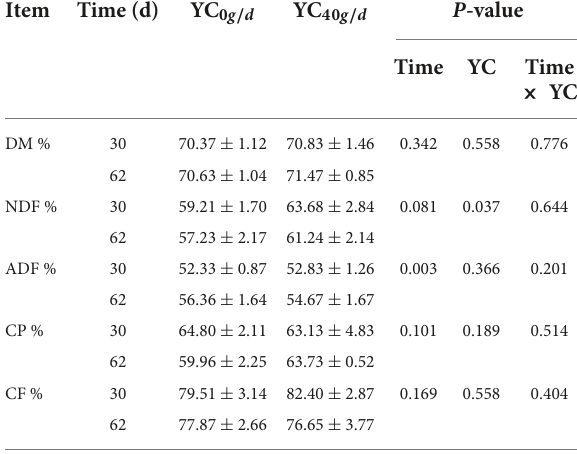
TABLE 3 Effect of feeding YC on nutrient digestibility of growing bulls on days 30 and 62.